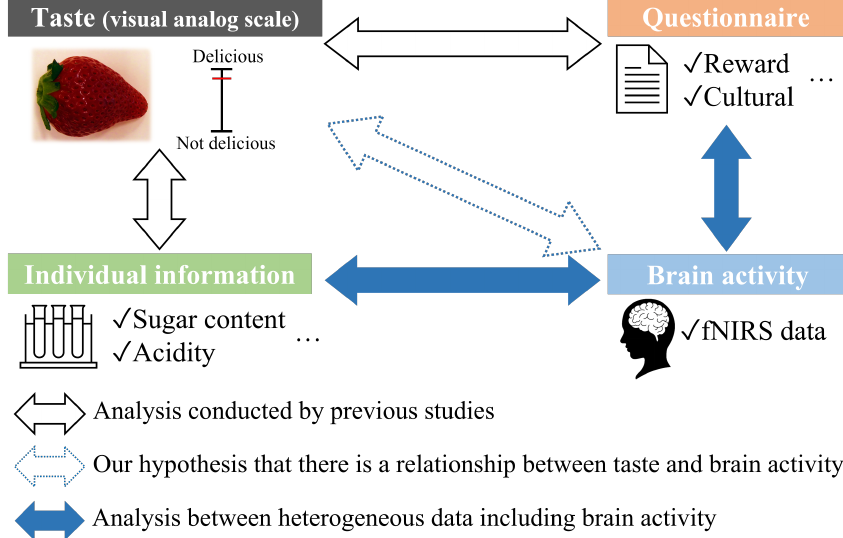
Figure 1. Overview of the differences between the analyses conducted in previous studies and the analysis conducted in this study. The black arrow indicates the analyses conducted by previous studies. The blue arrows and the blue arrows with broken lines indicate our hypothesis and analyses of heterogeneous data,